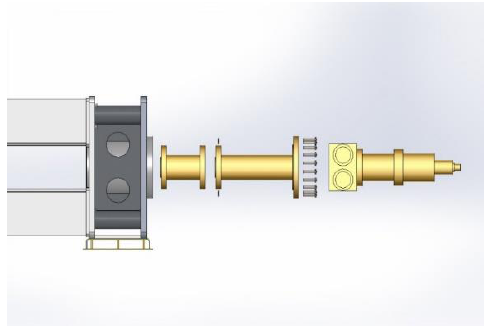
Figure 10. Disassembled diagram of the shaft end loading mechanism.